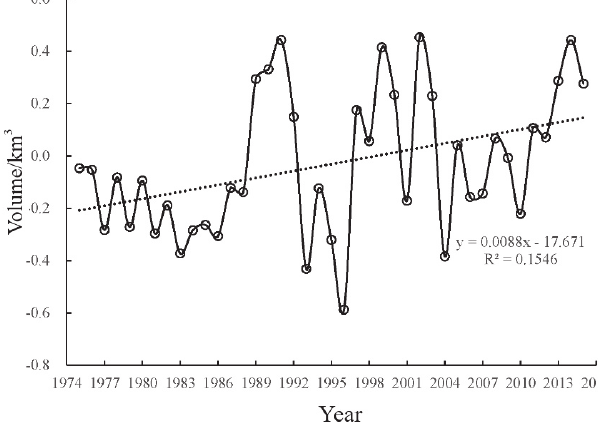
Figure 5. Volume changes time-series during 1975-2015 of Taihu